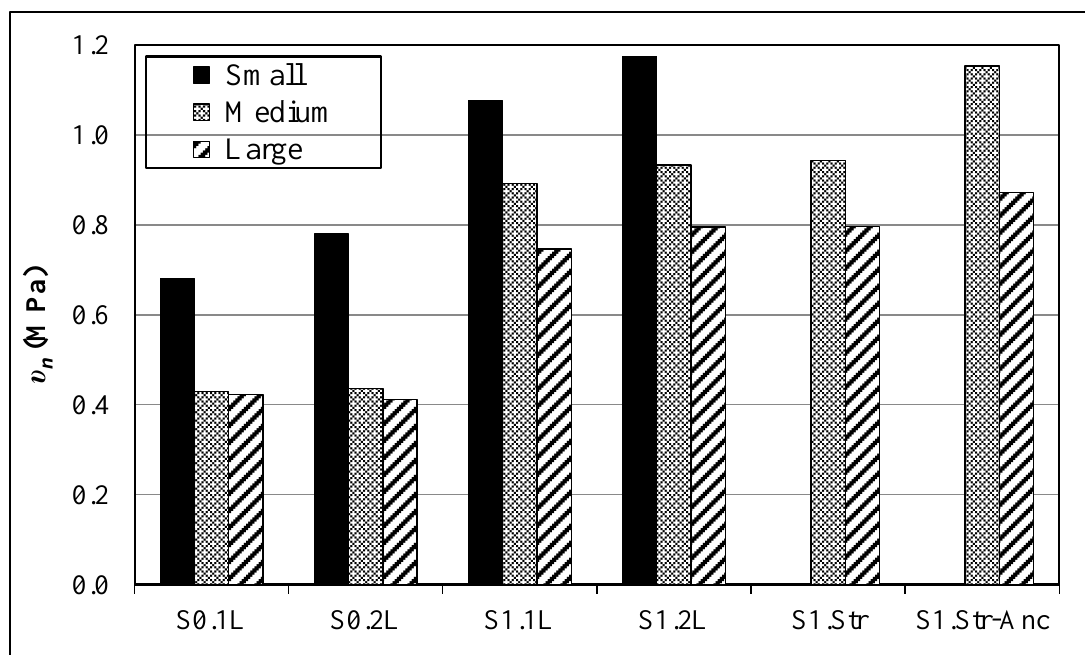
Figure 5. Influence of beam size on the normalized shear strength.